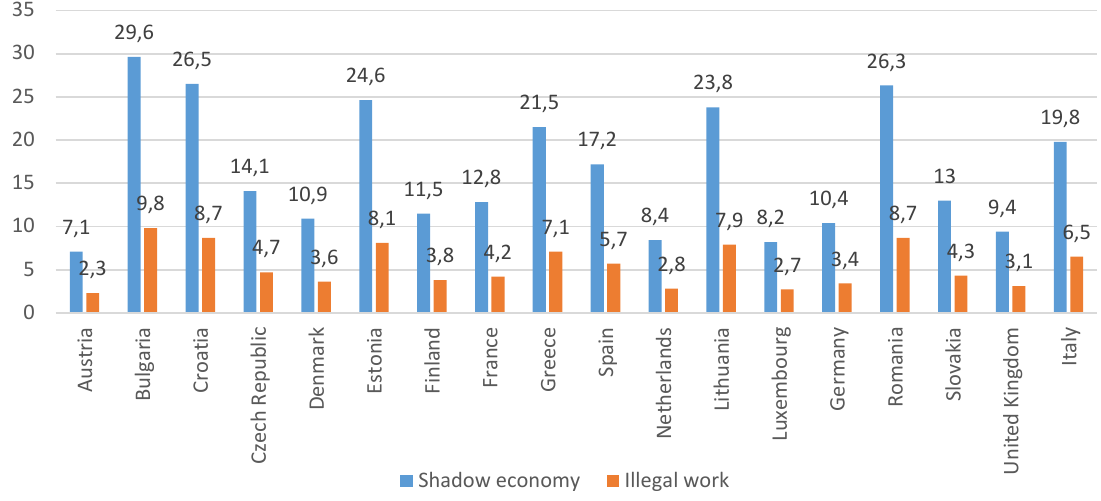
Figure 1. Informal economy and the level of undeclared work according to Schneider in the selected EU countries in 2017 (in